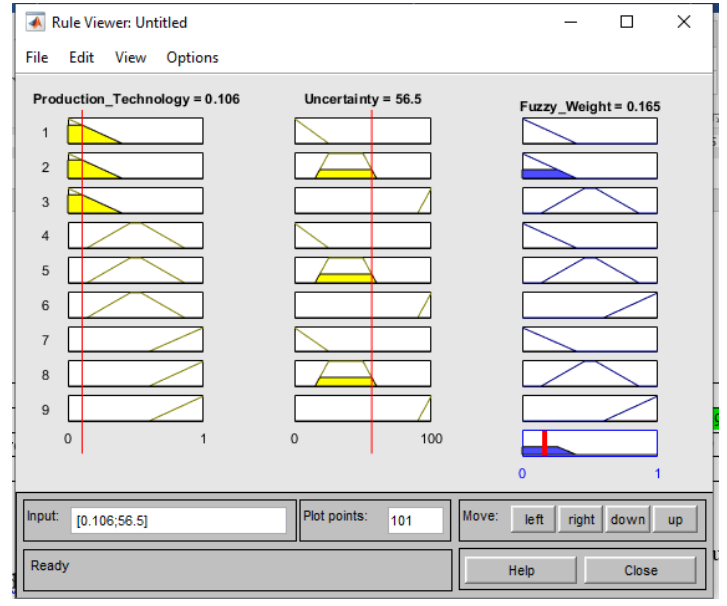
Figure 8. Fuzzy weights output window.